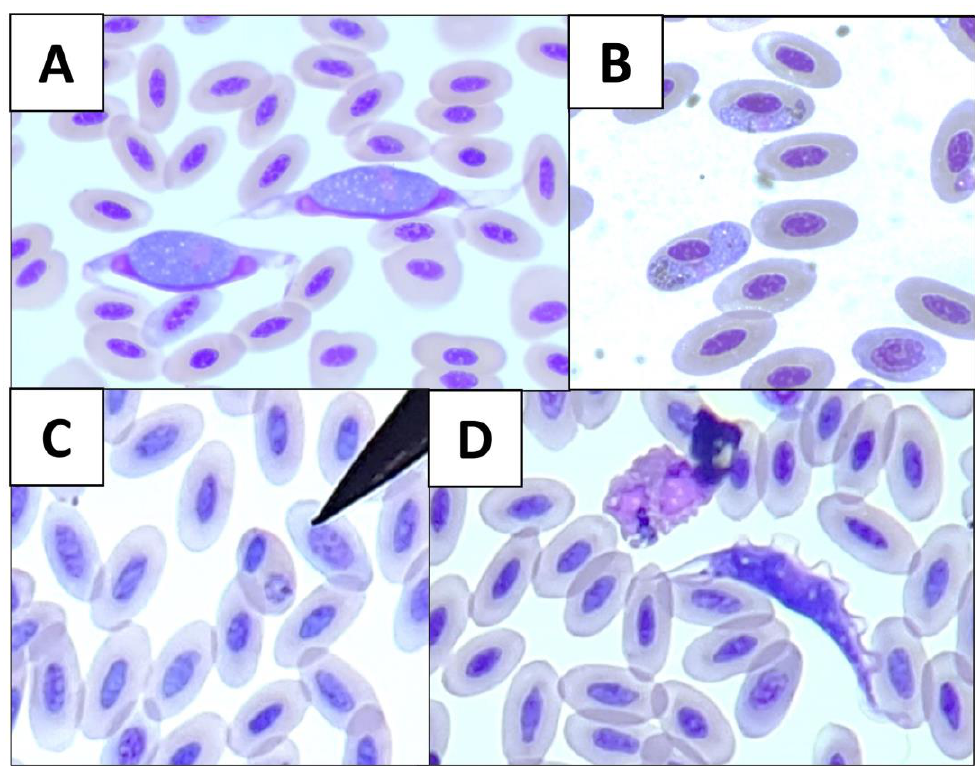
Figure 1. Microscopical photographs of blood parasite genera from wild birds at 1000×: ( A ) Leucocytozoon ; ( B ) Haemoproteus ; ( C ) Plasmodium ; and ( D ) Trypanosoma .